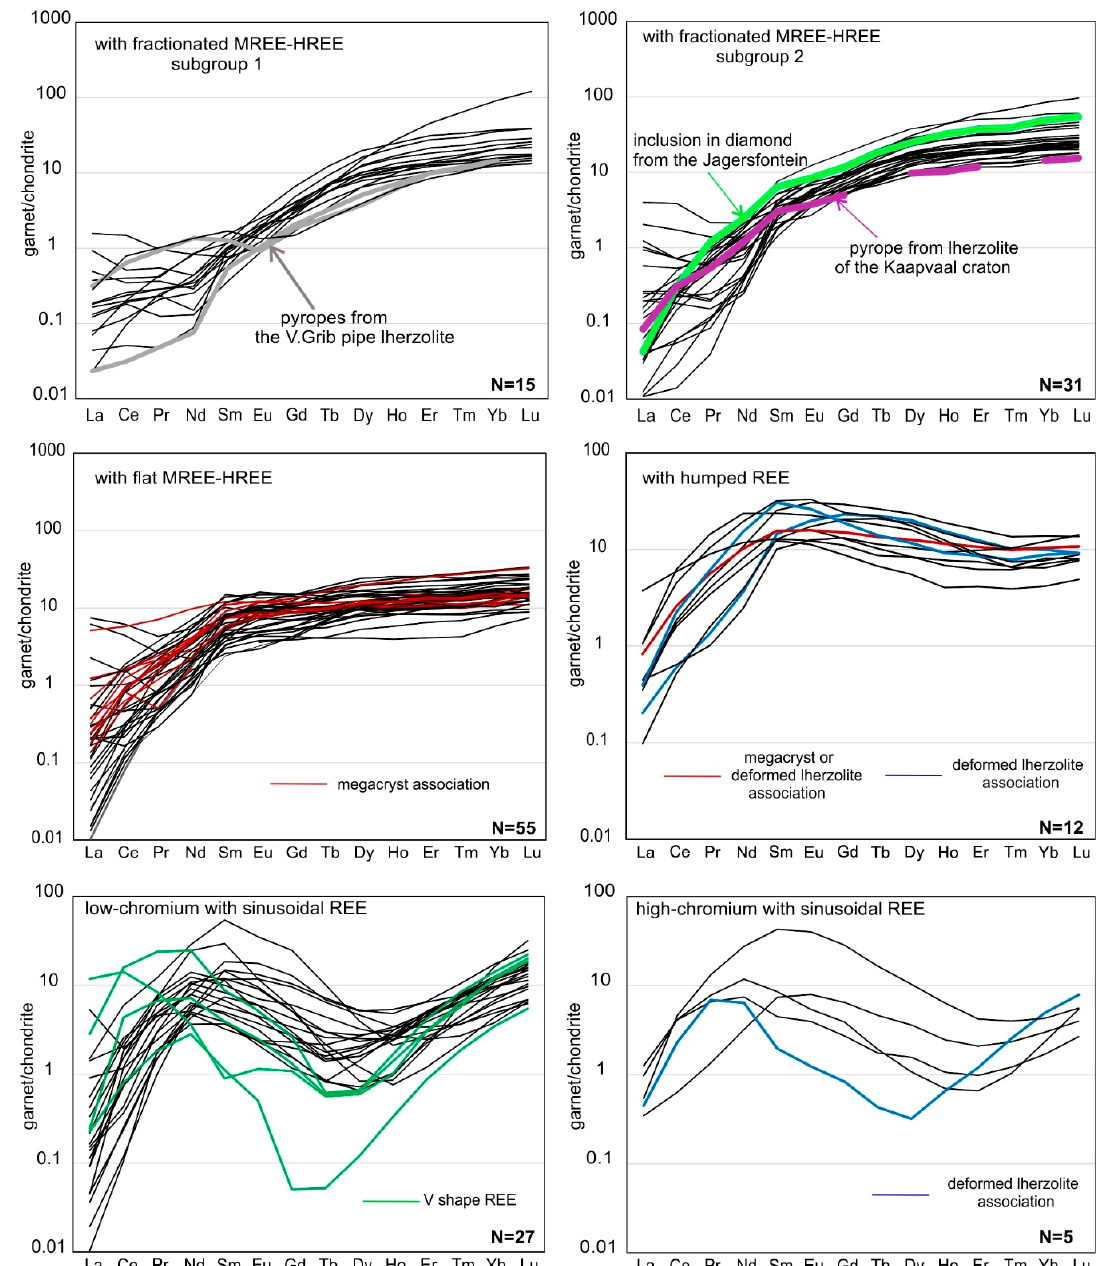
Figure 3. Chondrite-normalized [11] REE patterns of pyropes from the southern area of Arkhangelsk region. Pyropes from the V. Grib pipe lherzolites [14], inclusion in diamond from the Jagersfontein [20], and pyrope of lherzolite from the Kaapvaal craton [21]. N, number of grains analyzed. On the Cr 2 O 3 vs. CaO diagram, pyropes of the first group matched the low-chromium (Cr 2 O 3 = 1–3.5 wt. %; average Cr 2 O 3 = 2.1 wt. %) lherzolitic field (Figure 2A). Additionally, these pyropes had